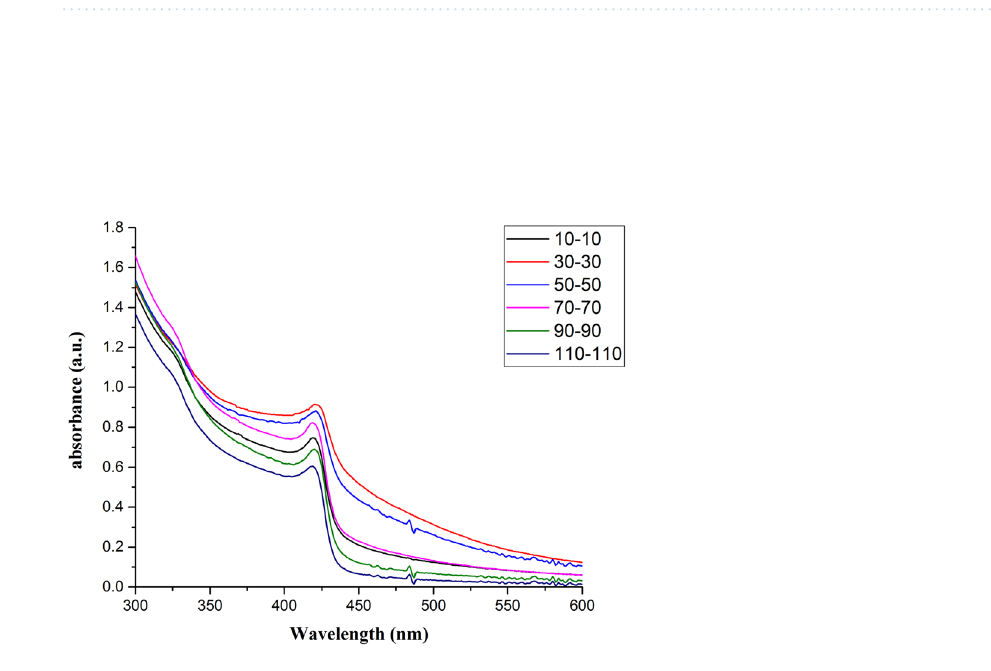
Figure 5. UV–Vis analysis